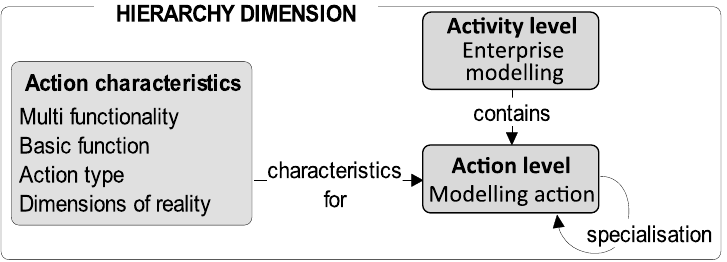
Figure 5. Conceptualization of the hierarchy dimension